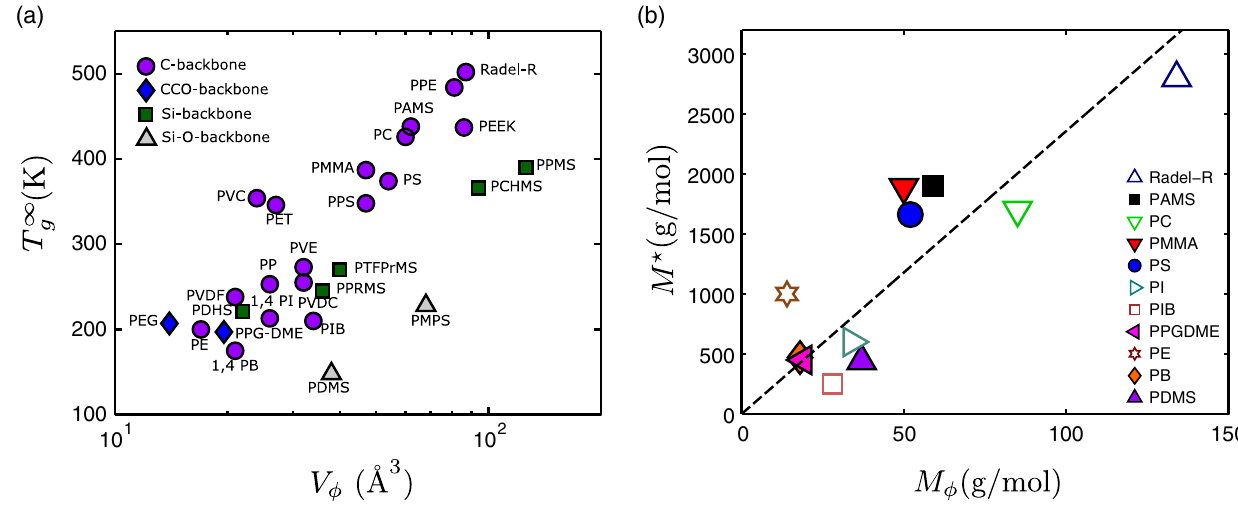
FIG. 12. (a) T ∞ vs V ϕ for the polymer systems in Table V. The different symbols or colors refer to different backbone chemistries. g (b) M ⋆ vs M ϕ . The dashed line is a linear fit yielding M ⋆ ≃ 24 M ϕ . Open symbols in panel (b) denote polymers with less certainty in M (cid:2) M Þ due to data that do not cover all three regimes in T g ð